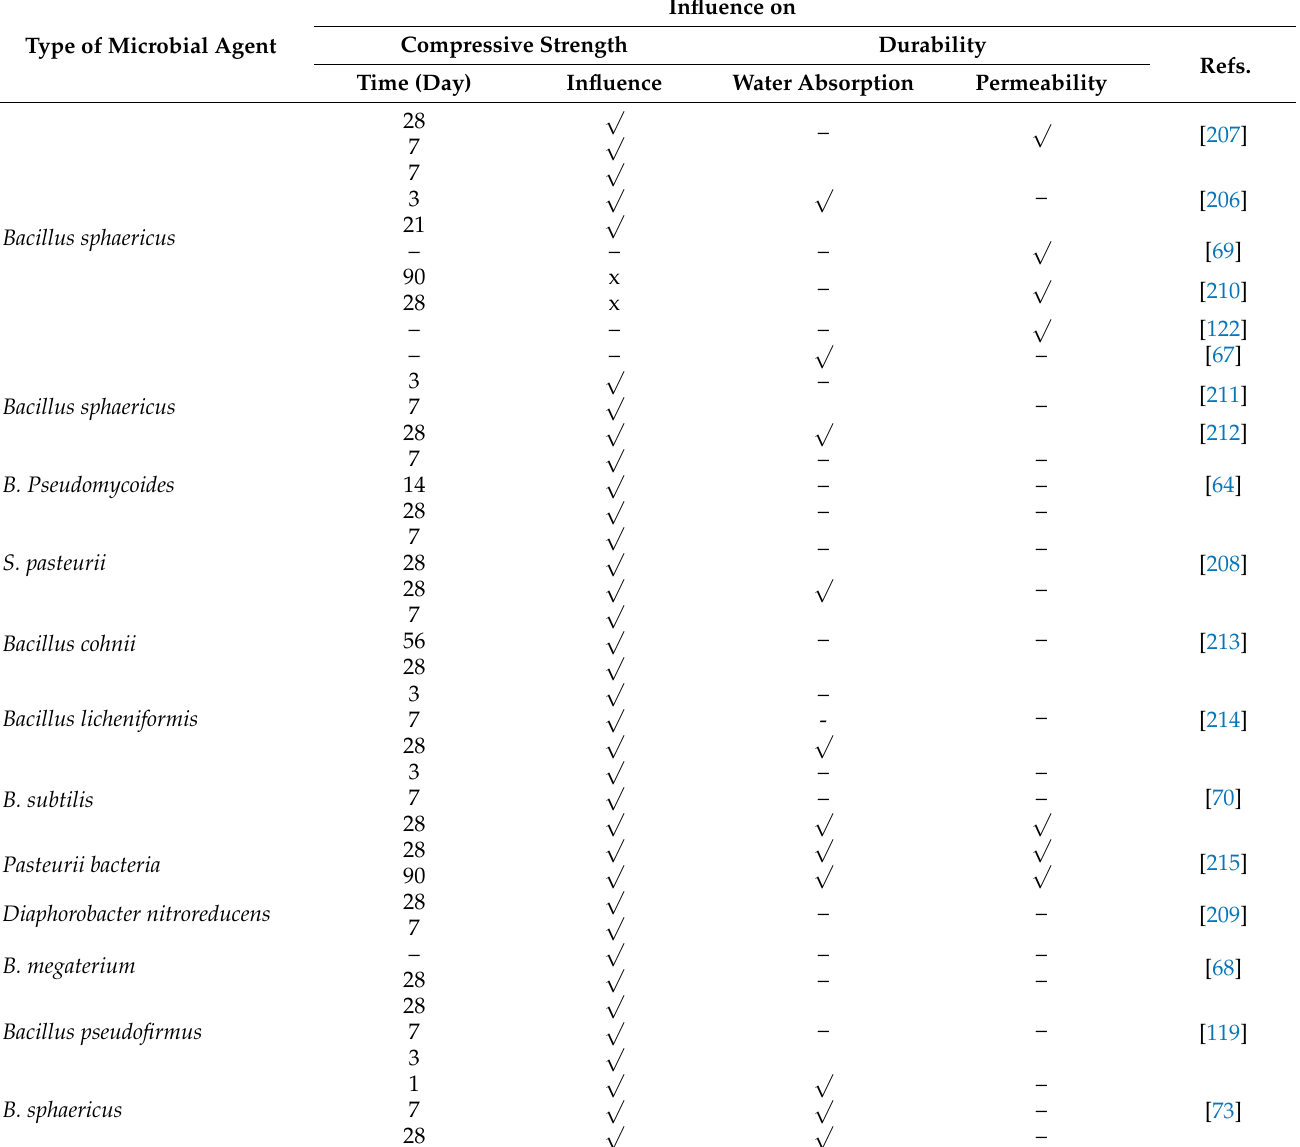
Table 6. Influence of microbial agents on permeability, compressive strength, and water absorption.